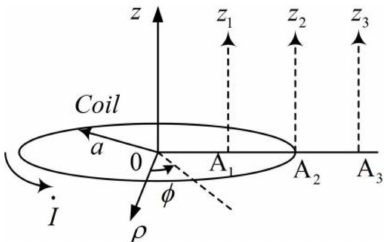
Figure 7. The three points are in ρ axis.